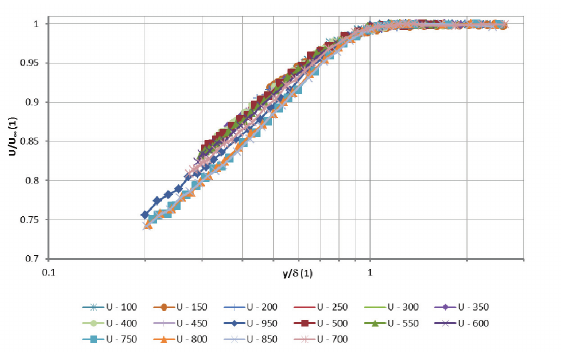
Fig. 4 Dimensionless velocity profiles U/U x =(100 − 950) mm. Unheated plate.